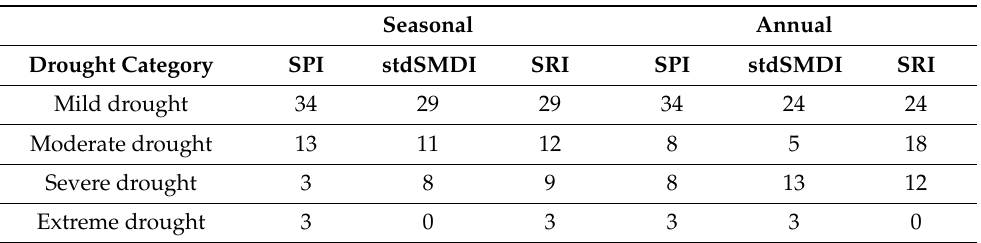
Table 6. Frequency of occurrence (%) of each drought category during seasonal and annual aggregate periods of the three drought